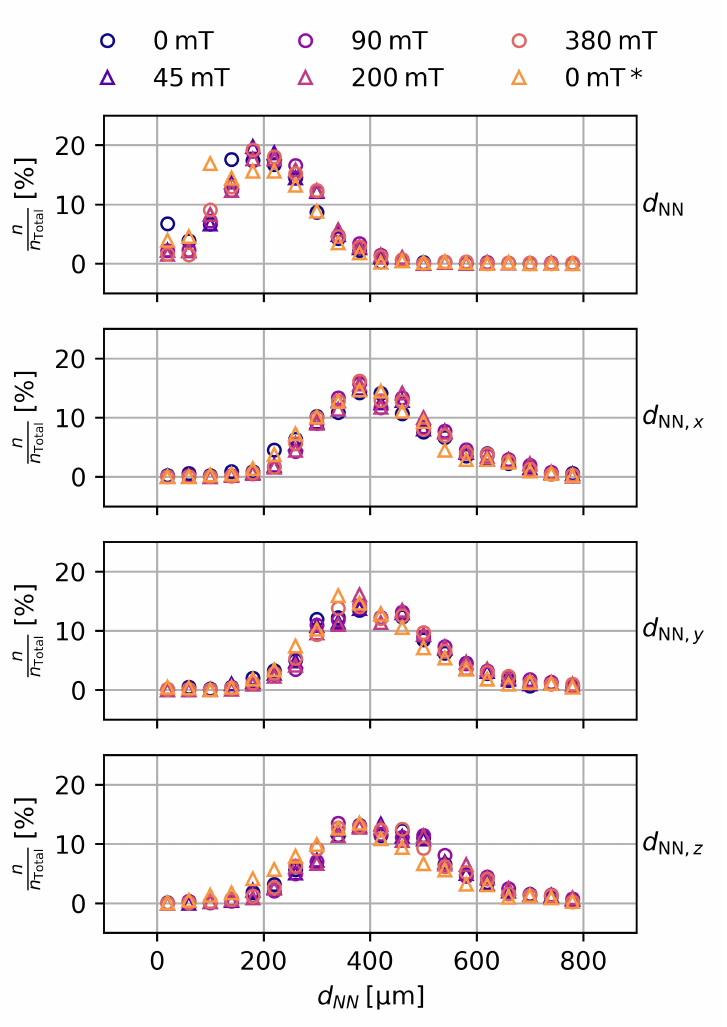
Figure 5. Distributions of the isotropic and anisotropic distances d NN . In the isotropic case, all neighbors of a particle are considered, while only the nearest neighbor within a 45° double cone along the x -, y -, and z -axis of a particle are considered in the anisotropic case. Data are shown for a sample with w s = 10% and c NaCl = 0molL − 1 with increasing magnetic flux